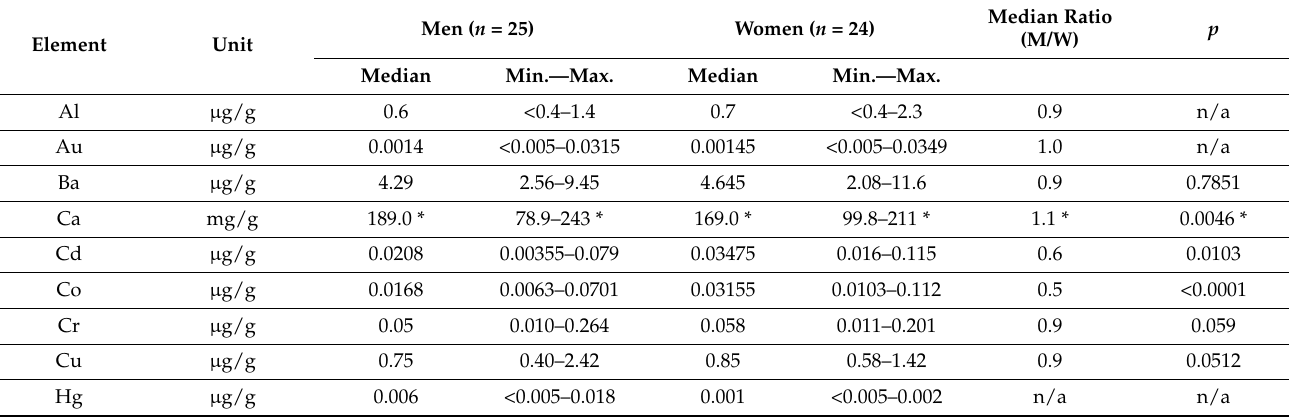
Table 5. Concentrations of metals and trace elements in the tissue of calcified aortic valves of patient group—comparison of men and